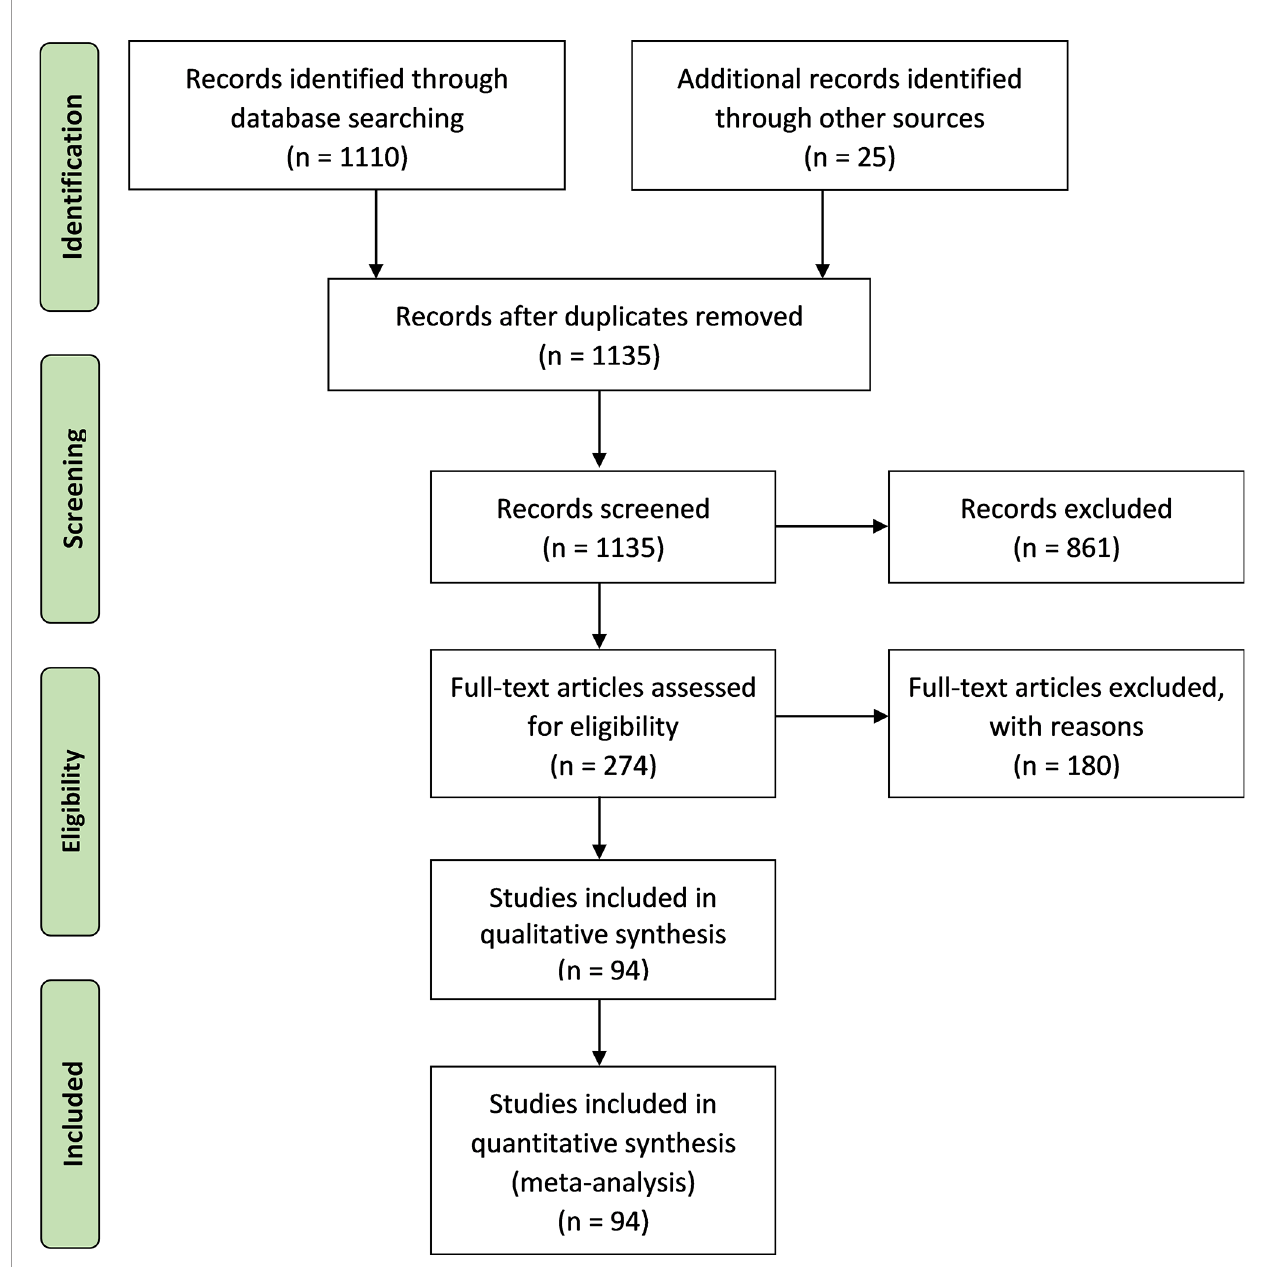
FIGURE 1 | Flow diagram for literature review with the Preferred Reporting Items for Systematic reviews and Meta-Analyses